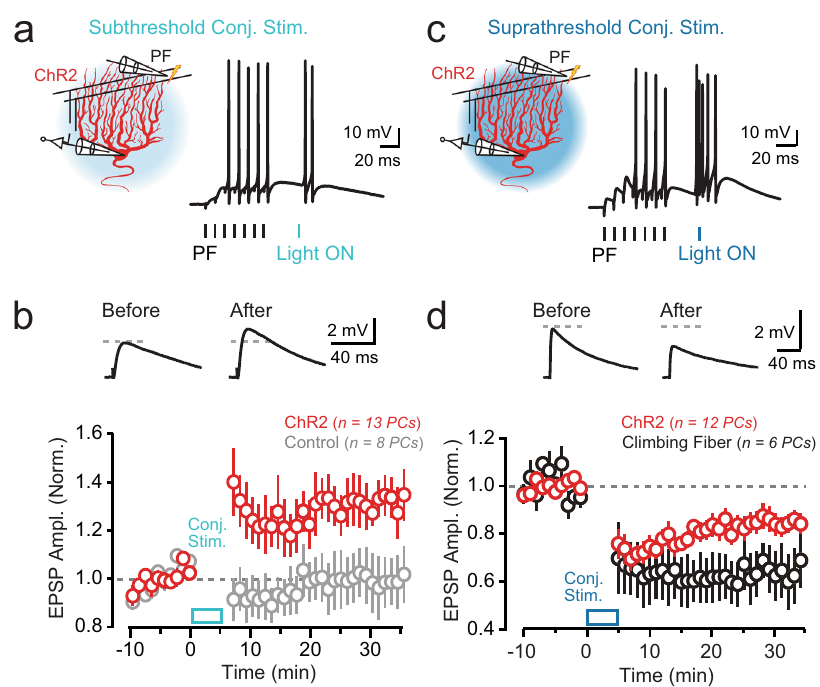
Fig. 2 Optogenetic PC activation induces synaptic plasticity. a During PC recordings, a parallel fi ber (PF) tetanus (100 Hz, 70 ms) preceded an optogenetically induced stimulus ( Δ 25 ms); light power was subthreshold for evoking dendritic spike fi ring ( λ 461 nm; 5 ms; 0.15 mW/mm 2 ). This pairing was delivered for 300 repetitions (1 Hz). b Top: average test EPSPs to parallel fi ber stimulation before and after the conjunctive pairing procedure. Bottom: plot of change in EPSP amplitude across PCs shows optogenetically induced LTP (red). Test EPSP amplitude was not affected by the light-pairing procedure when recording in non-ChR2-expressing control PCs (gray). Data were obtained from 12 mice. c In separate recordings, the parallel fi ber tetanus was paired with an optogenetic stimulus suprathreshold for evoking dendritic spike initiation ( λ 461 nm; 5 ms; 1.7 mW/mm 2 ). d Top: average test EPSPs before and after the conjunctive pairing procedure with high-power light. Bottom: summary plot of EPSP amplitude across PCs shows optogenetically induced LTD (red), the same polarity of plasticity induced by pairing the parallel fi ber tetanus with a climbing- fi ber stimulus in place of the light pulse (black). Data were obtained from 14 mice. In the plots, data are presented as mean ±